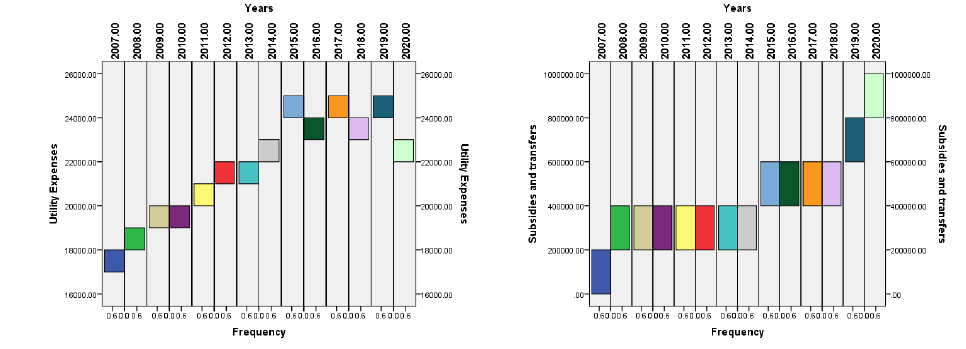
Figure 6. Utility expenses Figure 7. Subsidies and transfers